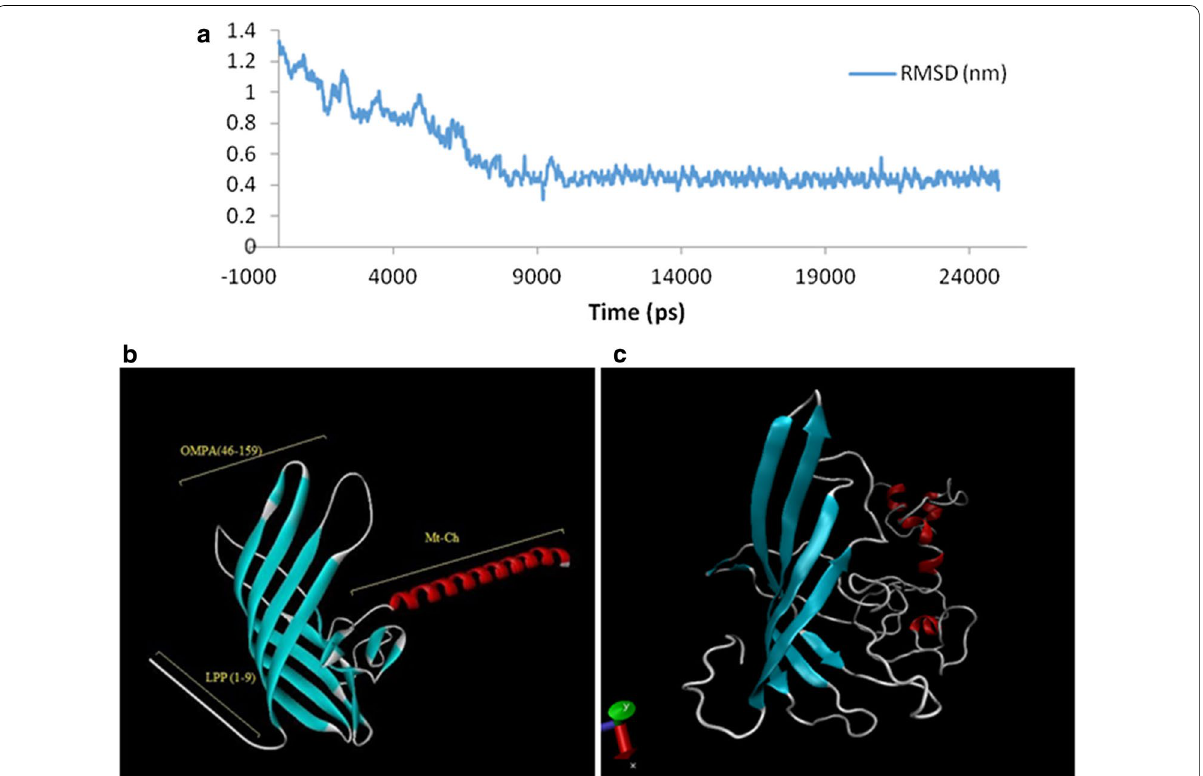
Fig. 2 a RMSD analysis of complex conformation observed after 25 ns. The complex was stabilized from 10 to 25 ns. b LO-Mt-Ch complex before MD simulation that build with hyperchem software and c LO-Mt-Ch complex after 25 ns molecular dynamic simulation. Each secondary structure is shown as following color schemes: beta sheets (yellow), alpha helix (blue), 3/10-helix (purple), and turn (white), and bend